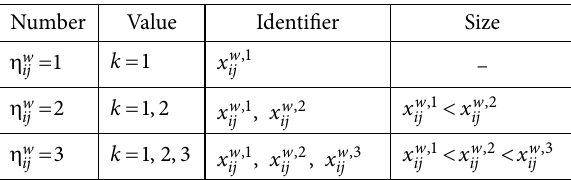
Table 2. Parameter symbols of movement s ij